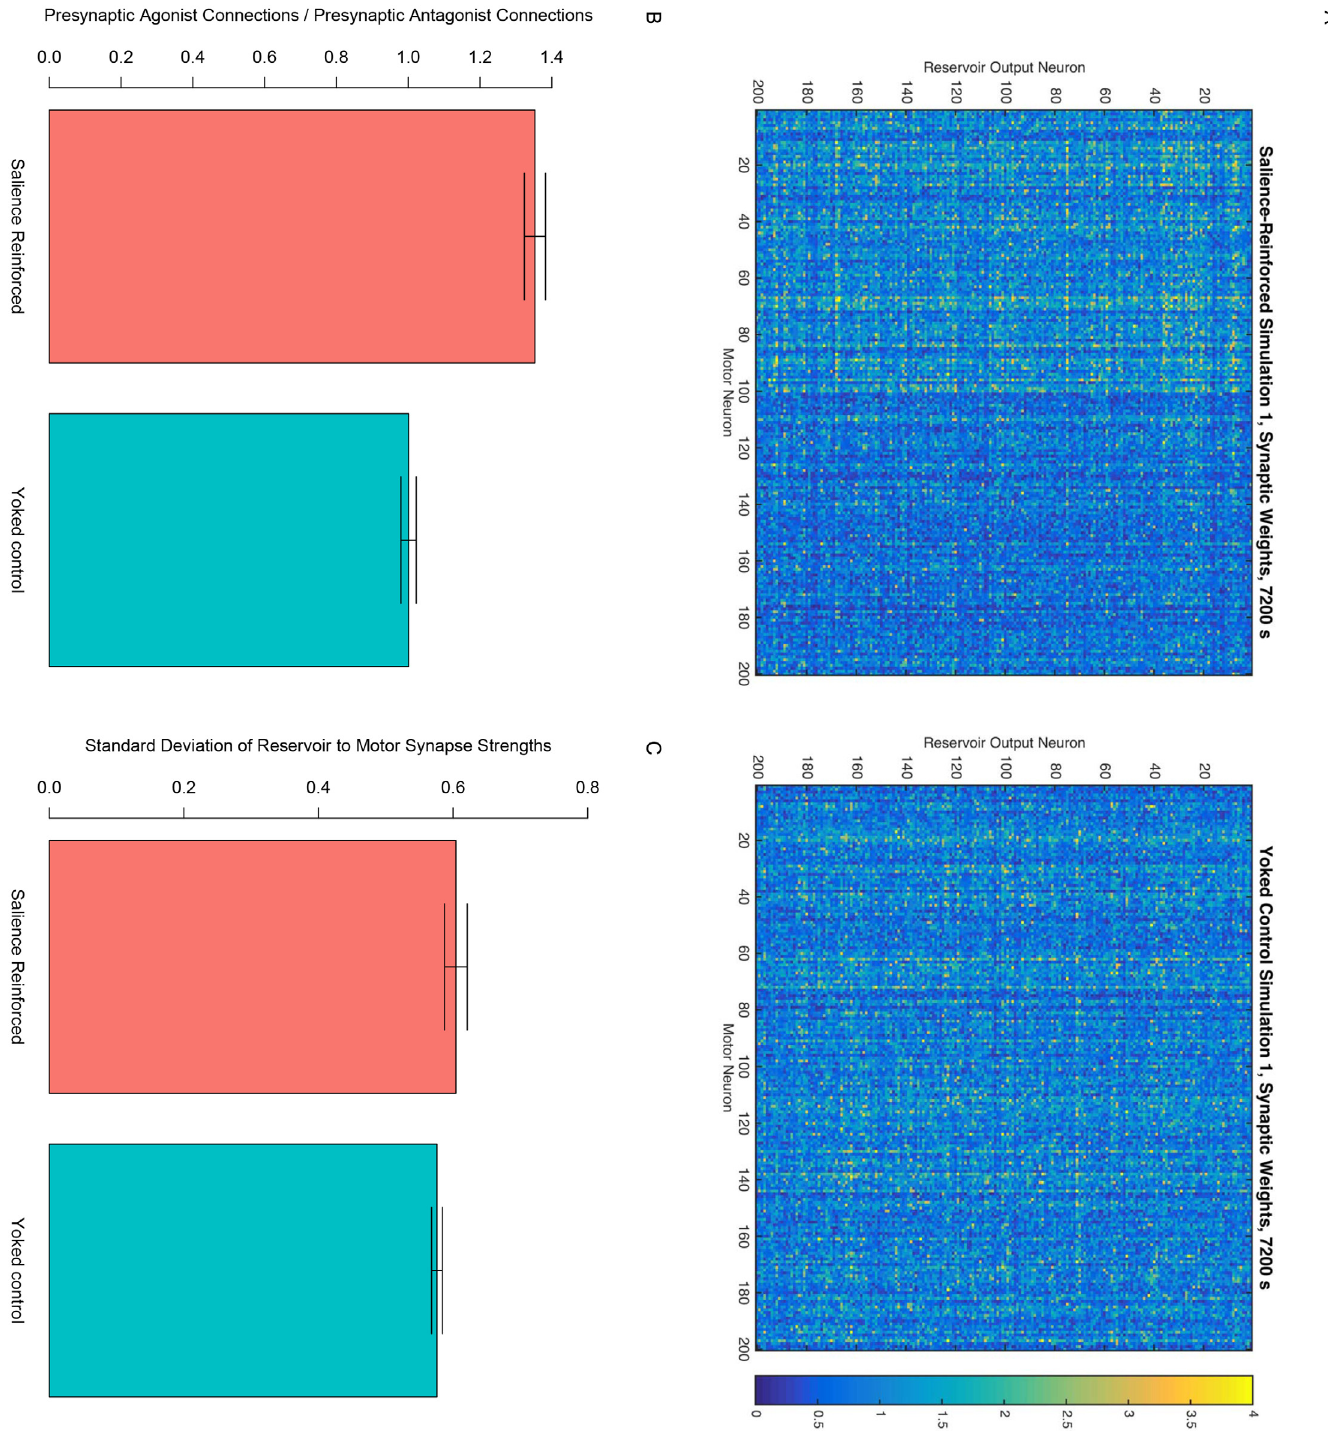
Fig 5. Synaptic weights after learning. A: Example of the synapse strengths from each reservoir output neuron to each motor neuron after learning. The left plot shows the synapses for the first simulation of the 200 motor neuron m = 2 model reinforced for high-salience vocalizations. The right plot shows the synapses for the corresponding yoked control simulation. Yellow indicates greater connection strengths; blue indicates weaker synapses. The stronger synapses on the left half of the left plot as compared to the right half of that same plot reflect the greater connection of reservoir neurons to agonist motor neurons promoting mouth closure than to antagonist motor neurons promoting mouth opening. Note that this bias is not present in the connection weights of the yoked control simulation shown on the right. B: Across all simulations of the 200 motor neuron m = 2 model, the total strength of the connections from